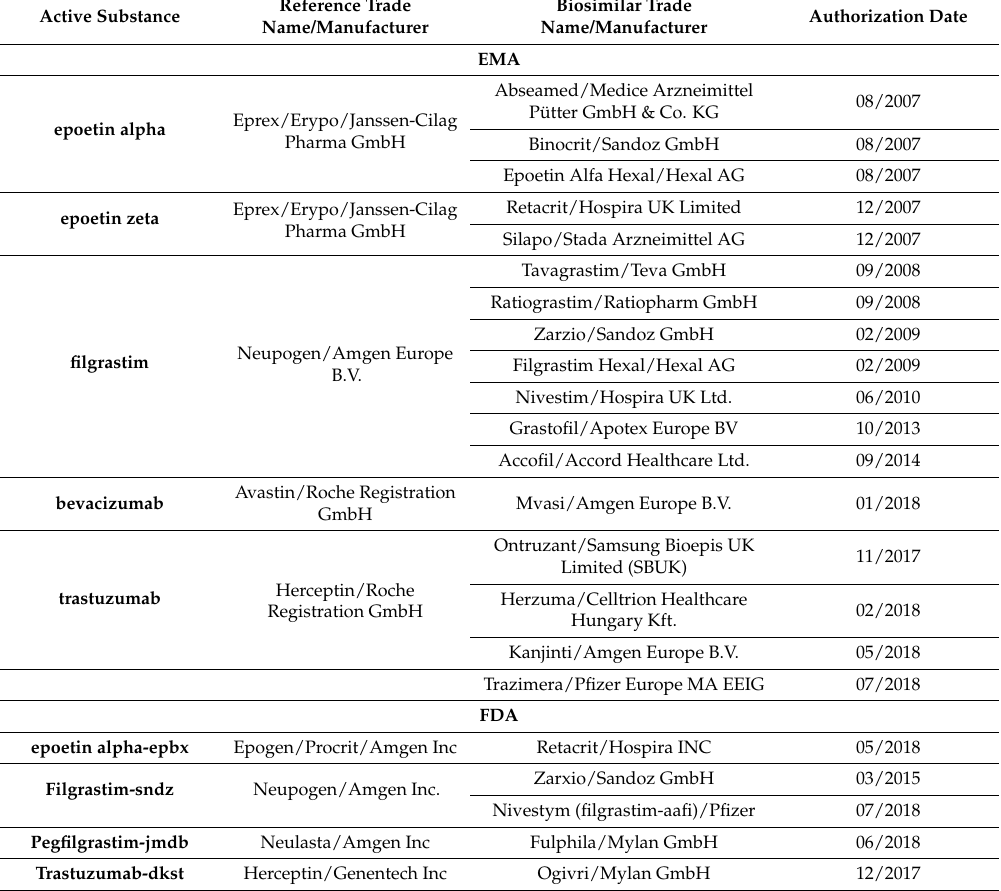
Table 1. Biosimilars approved by the European Medicines Agency (EMA) and the US Food and Drug Administration (FDA) which can be indicated in breast cancer therapy (August